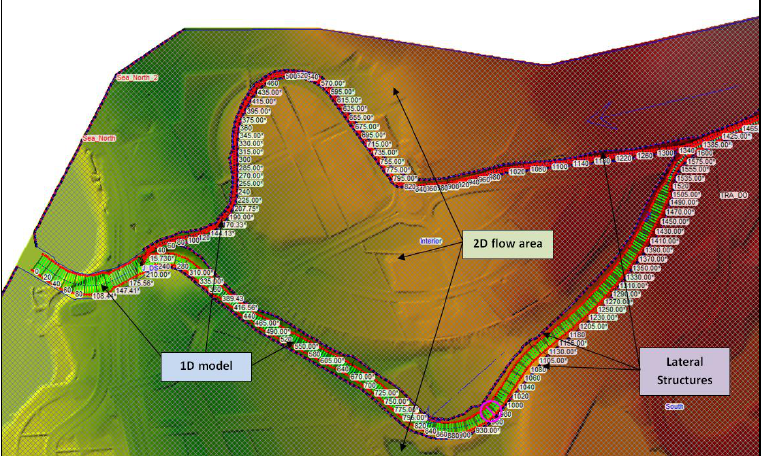
Figure 8. Screenshot of a section from the coupled 1D/2D model (as shown in the GUI of HEC-RAS Geometry Editor).